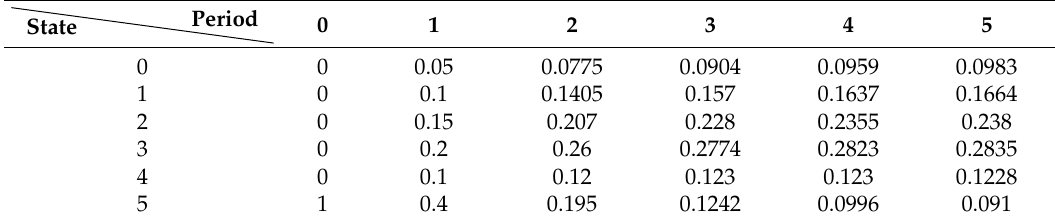
Table A2. Probability distribution of component 2 using the SMV approach.